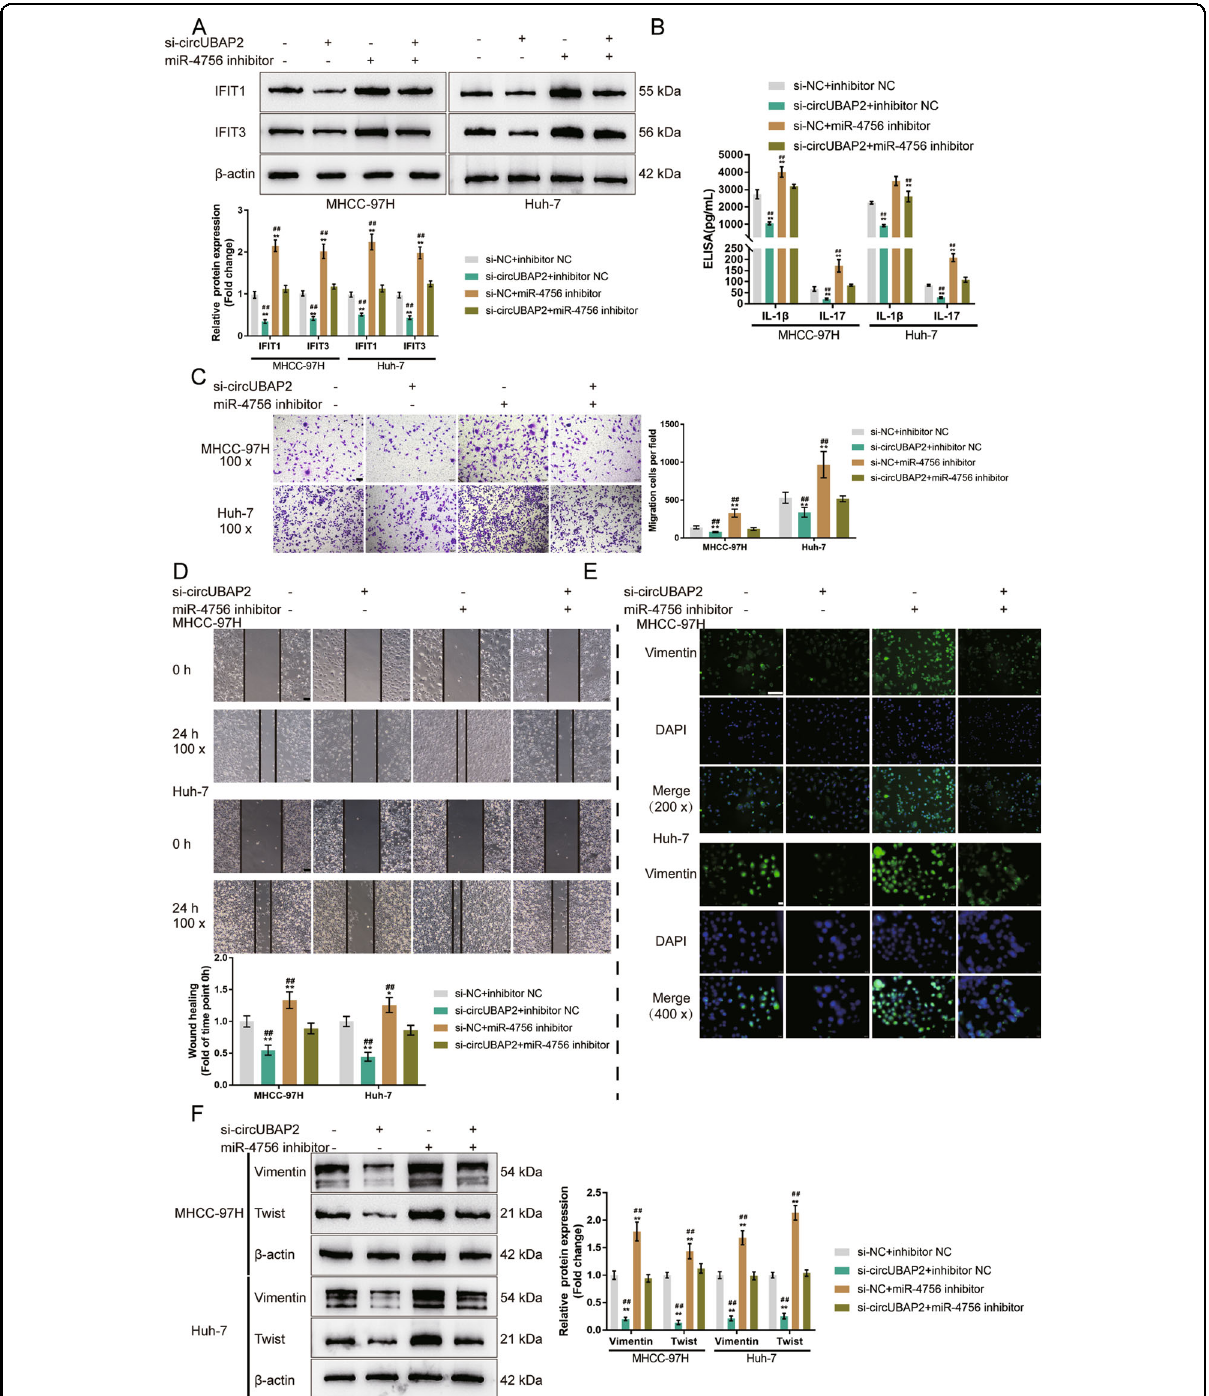
Fig. 7 Combined effects — effects of circUBAP2 and miR-4756 on IFIT1/IFIT3 expression and HCC cell phenotype. MHCC-97H and Huh-7 cells were co-transfected with si-circUBAP2 and miR-4756 inhibitor and examined for A The protein levels of IFIT1 and IFIT3 by Immunoblotting; B The concentrations of IL-1 β , and IL-17 in the culture medium by ELISA; C Cell migration by Transwell assay; D Cell migration by wound healing assay; E The cellular protein content and distribution of Vimentin was examined by IF staining; F The protein levels of Vimentin and Twist was examined by Immunoblotting. * P < 0.05, ** P < 0.01, compared with the si-NC + inhibitor NC group; ## P < 0.01, compared with the si-circUBAP2 + miR-4756 inhibitor